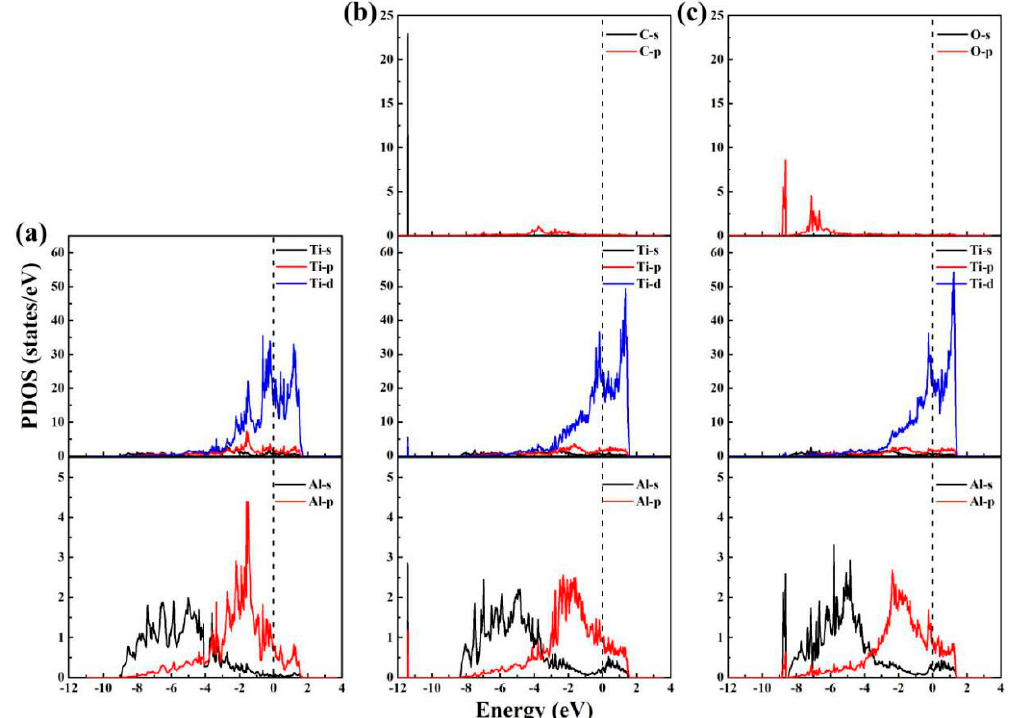
Figure 8. The partial densities of states of pure γ -TiAl ( a ), TiAlC ( b ), TiAlO ( c ).